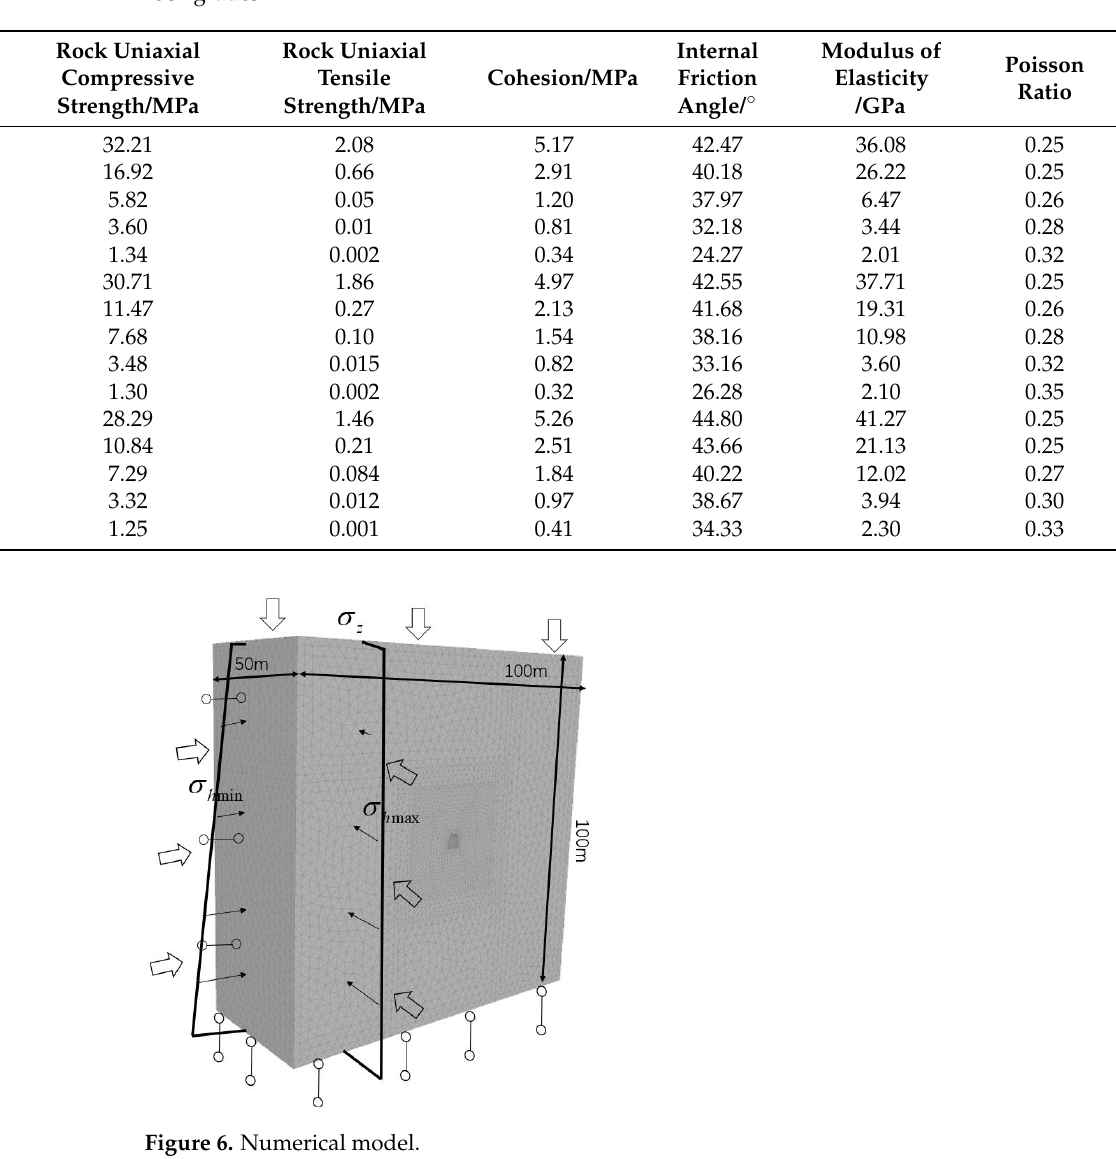
Table 4. Strength parameters of rock mass under different buried depths and different surrounding rock grades.